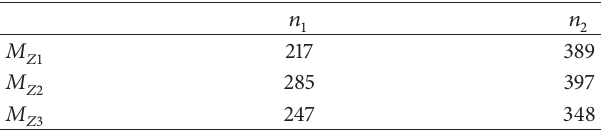
Table 2: Selected past index as a result from the constrained GA based